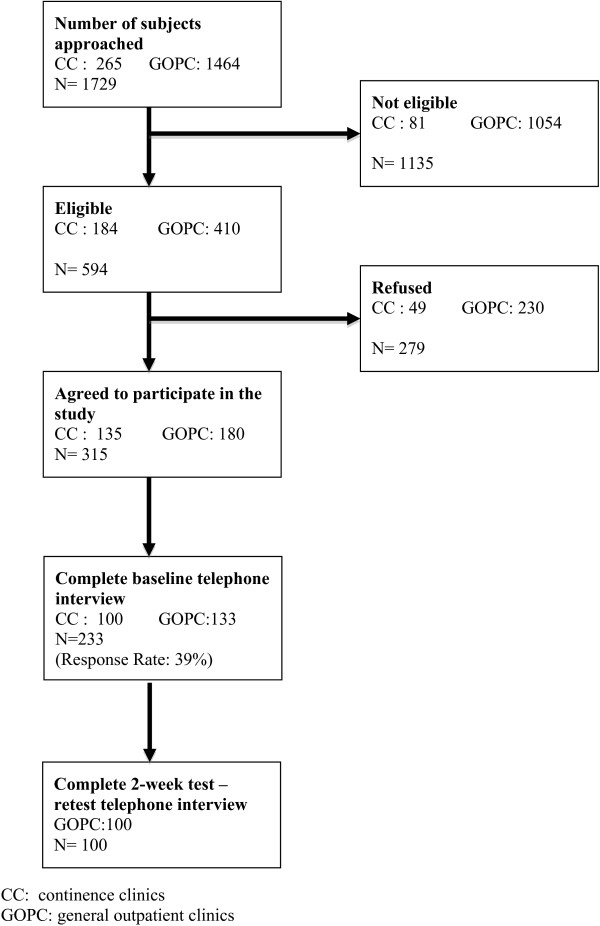
Subject recruitment flowchart.